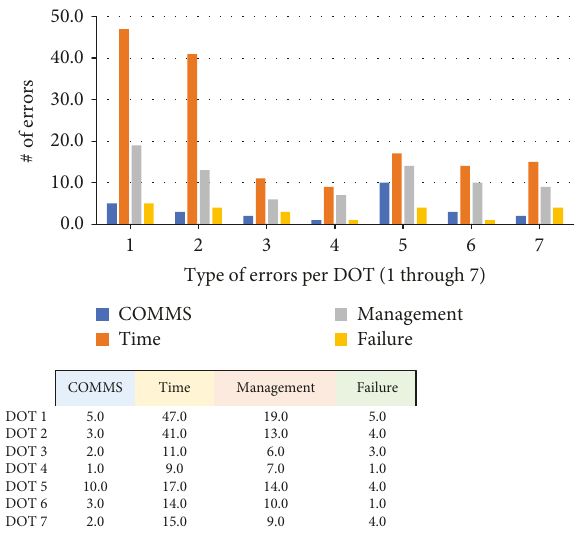
Figure 6: Distribution of type of errors per